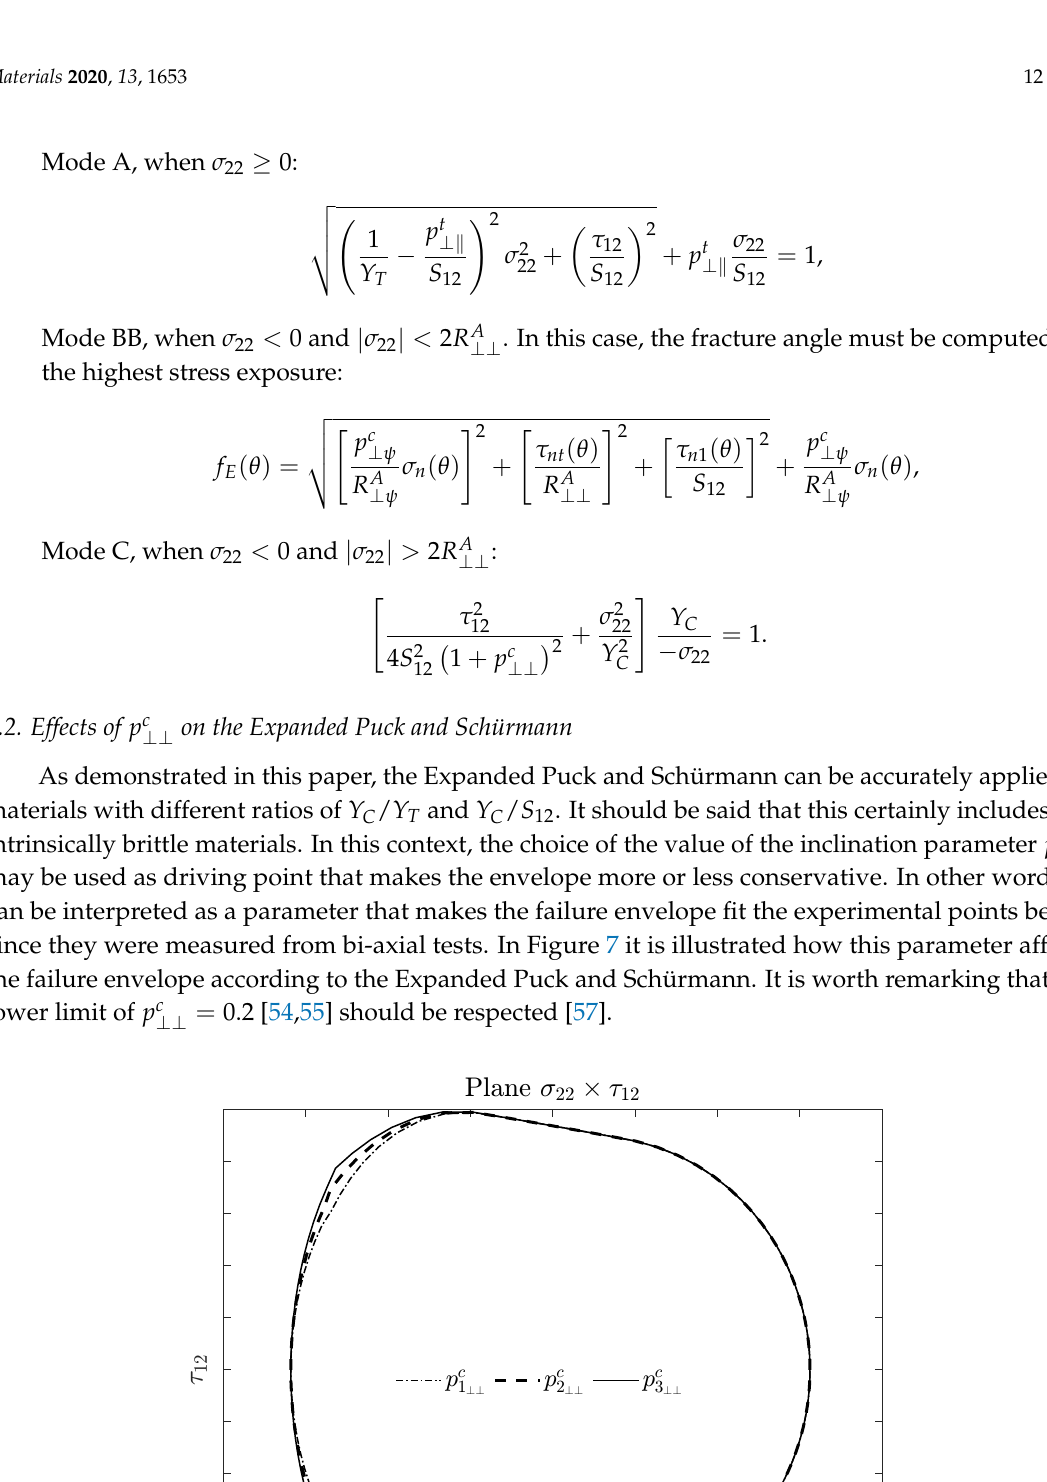
Figure 7. Effect of the inclination parameter p c This envelope was generated by the Expanded Puck and Schürmann criterion for a material with ratios Y C / Y T = 1.97 and Y C / S 12 = 0.95. In this figure p c